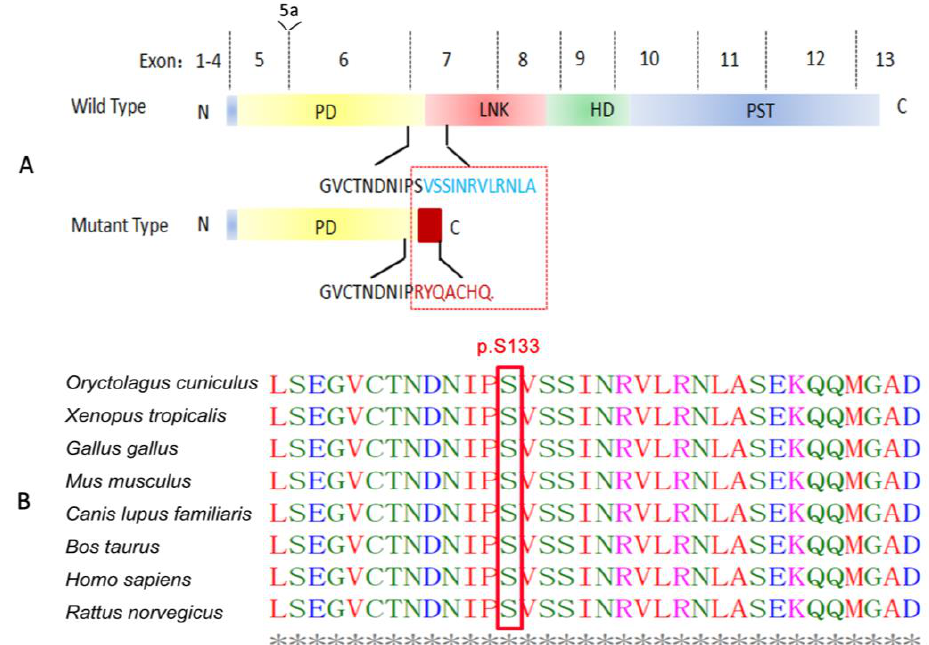
Figure 4. Schematic of predicted mutant PAX6 protein and bioinformatics analysis following ClustalW alignment. ( A ) Schematic of mutant PAX6 protein (lower panel) as predicted in this study compared with the wildtype PAX6 protein (upper panel). N, N terminus; PD, paired domain; LNK, linker domain; HD, homeodomain; PST, proline, serine, and threonine-rich domain; C, C terminus. Due to the frameshift duplication, the peptide in blue encoded by exon 7 of the wildtype is replaced by the peptide in red in the mutant in the box. ( B ) The PAX6 mutation c.391_398dupATACCAAG involves a highly conserved residue. The serine at position 133 is highly conserved for PAX6, as demonstrated by an analysis of orthologs from eight different species: rabbit, tropical clawed frog, chicken, house mouse, dog, cattle, human, and Norway rat. Table 2. Summary of the PAX6 gene and its variant.